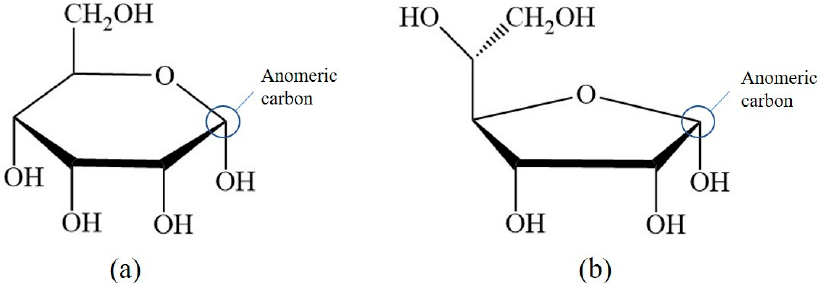
Figure 5. Structures of monosaccharides ( a ) α -pyranose and ( b ) α -D-allofuranose displaying axial positioning on the anomeric carbon.